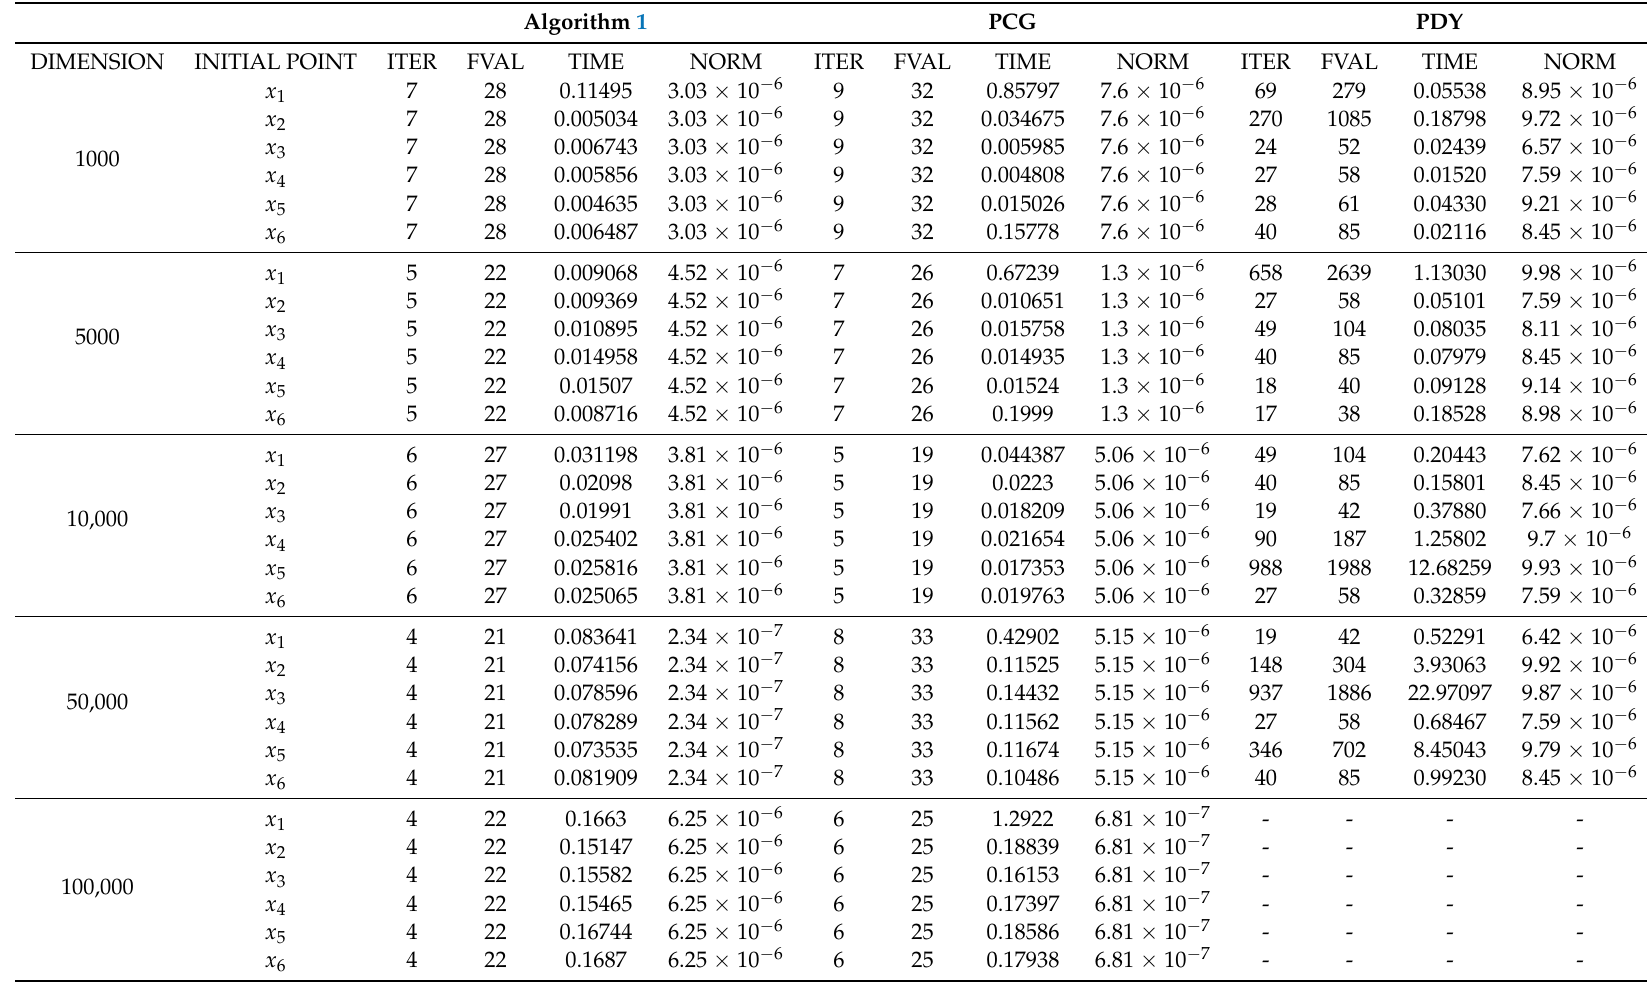
Table 8. Numerical Results for Algorithm 1 (DCG) , PCG and PDY for Problem 8 with given initial points and